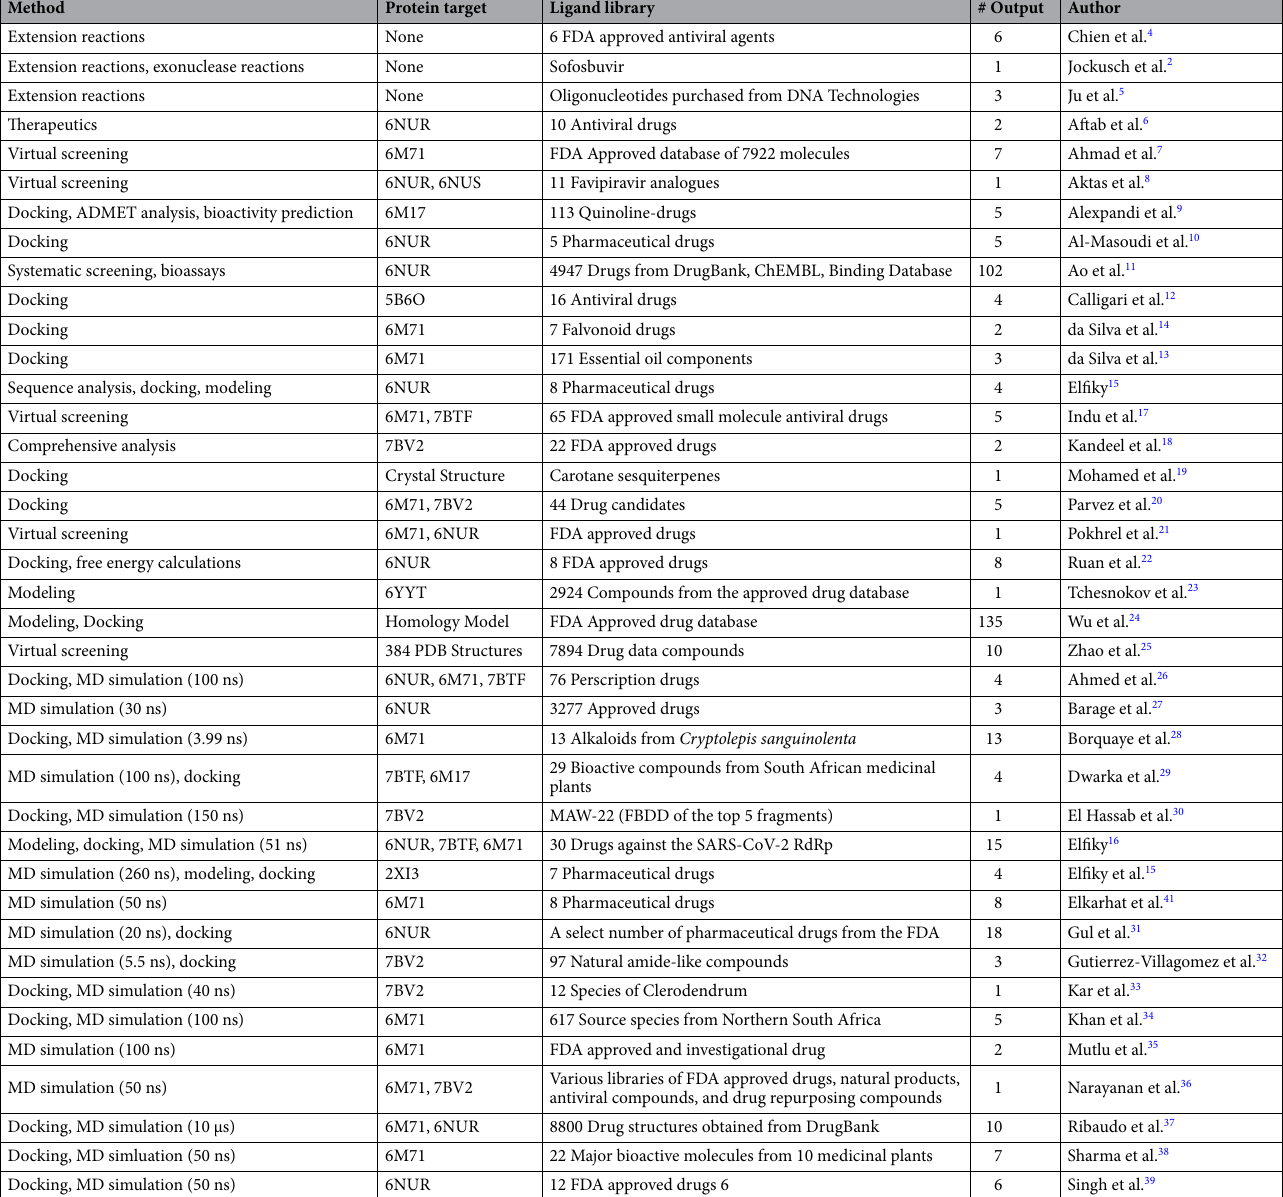
Table 1. Survey of the current studies on the discovery and/or repurposing of approved drugs for the inhibition of SARs-COV-2